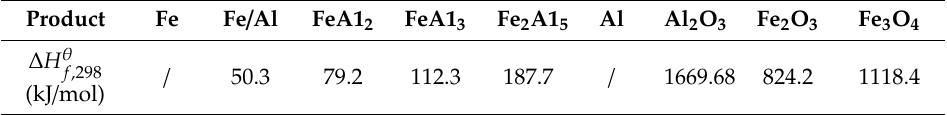
Table 4. Standard molar enthalpy of formation of the reaction products in the aluminum–iron system (including oxidation).